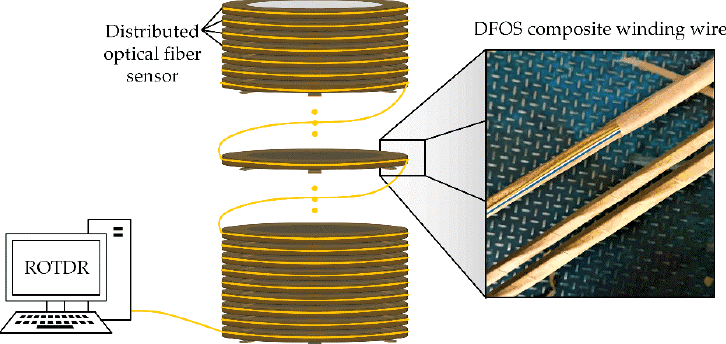
Figure 2. Schematic diagram of distributed sensing optical fiber composite winding.